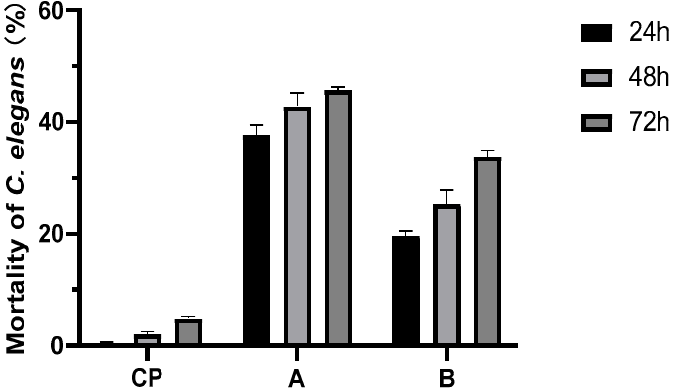
Figure 3. Nematicidal activities of ethyl acetate extracts of strain WH06 cultured in NB and LB media. CP represents blank control with 3% acetone. A represents the ethyl acetate extract of NB fermentation broth, and B represents the ethyl acetate extract of LB fermentation broth. Error bars represent the standard error of the mean ( n = 3).